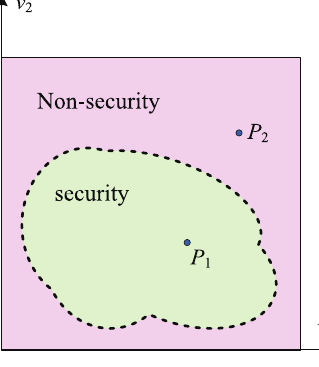
Fig. 1. Schematic diagram of safety